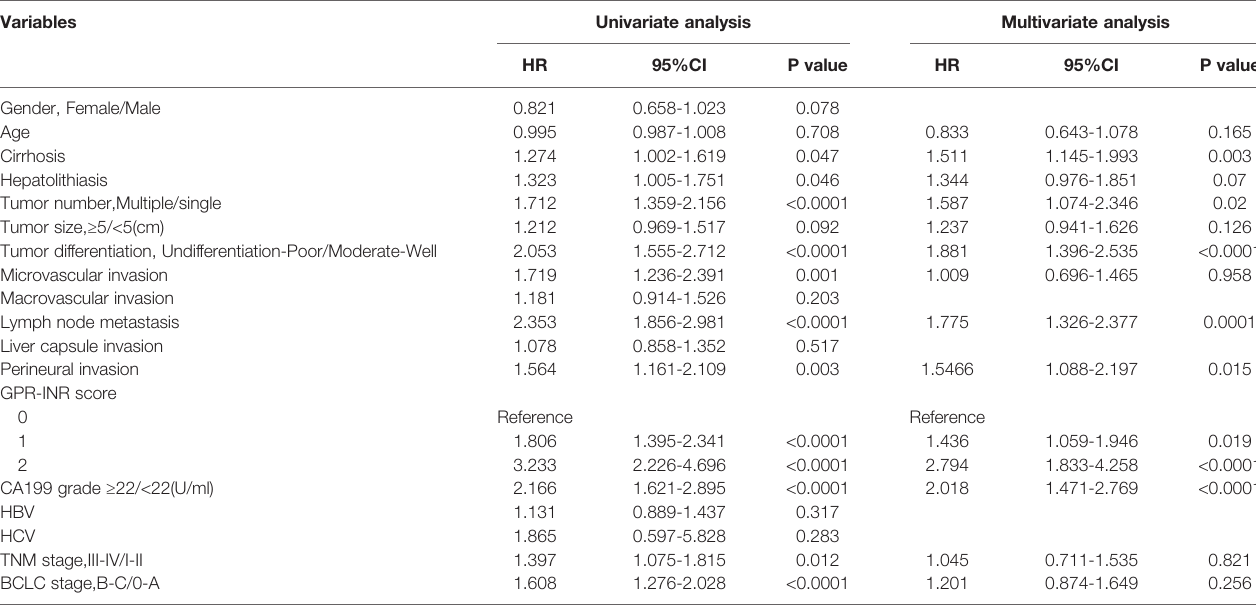
TABLE 2 | Univariate and multivariate analyses to determine independent predictors of overall survival.